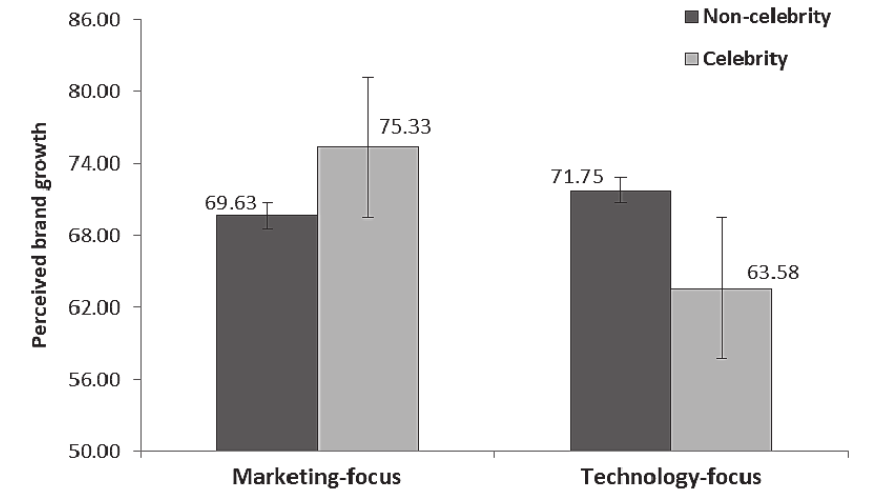
<Figure 1> The Effect of Strategic Focus and a Celebrity Endorsement Contract Announcement on Perceived Brand Growth (Note: Error bars based on 95% confidence